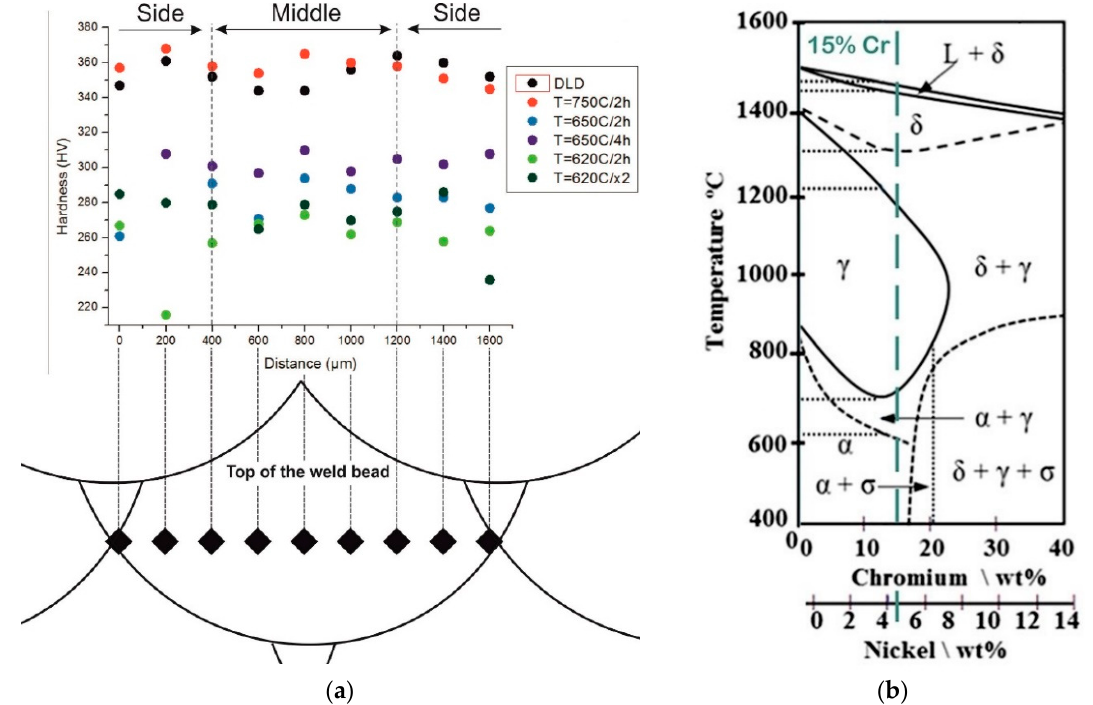
Figure 5. ( a ) microhardness; ( b ) the Fe–Cr–Ni equilibrium phase diagram [29].